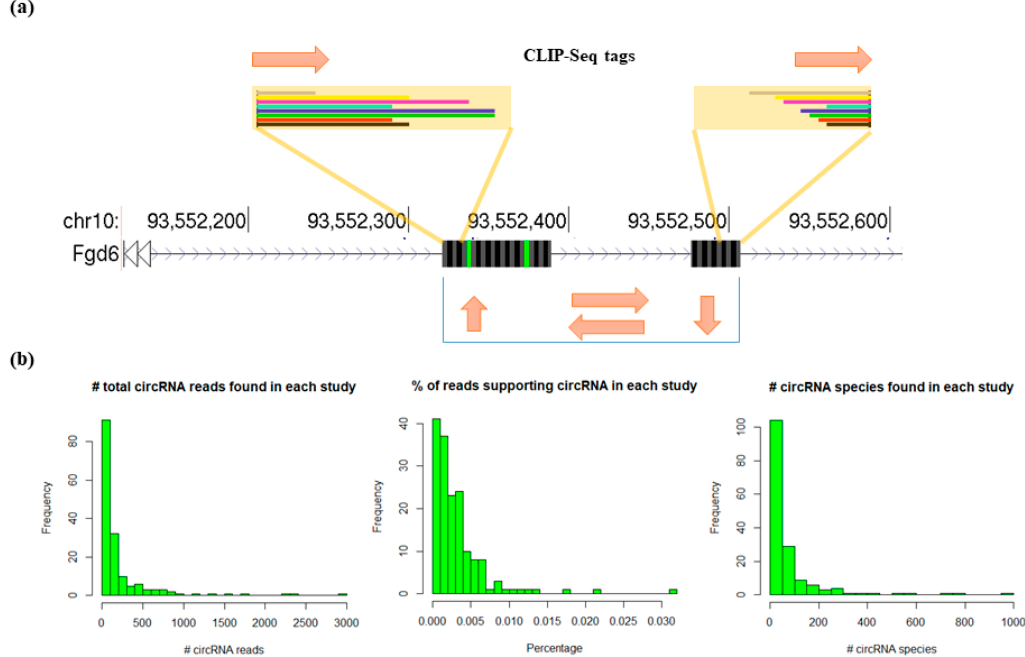
Figure 2. Overview of circRNAs bound by RBPs. ( a ) Exemplary circRNA bound by mouse RBP SRSF1. ( b ) Summary statistics of circRNAs bound by RBPs in all analyzed RBPs.